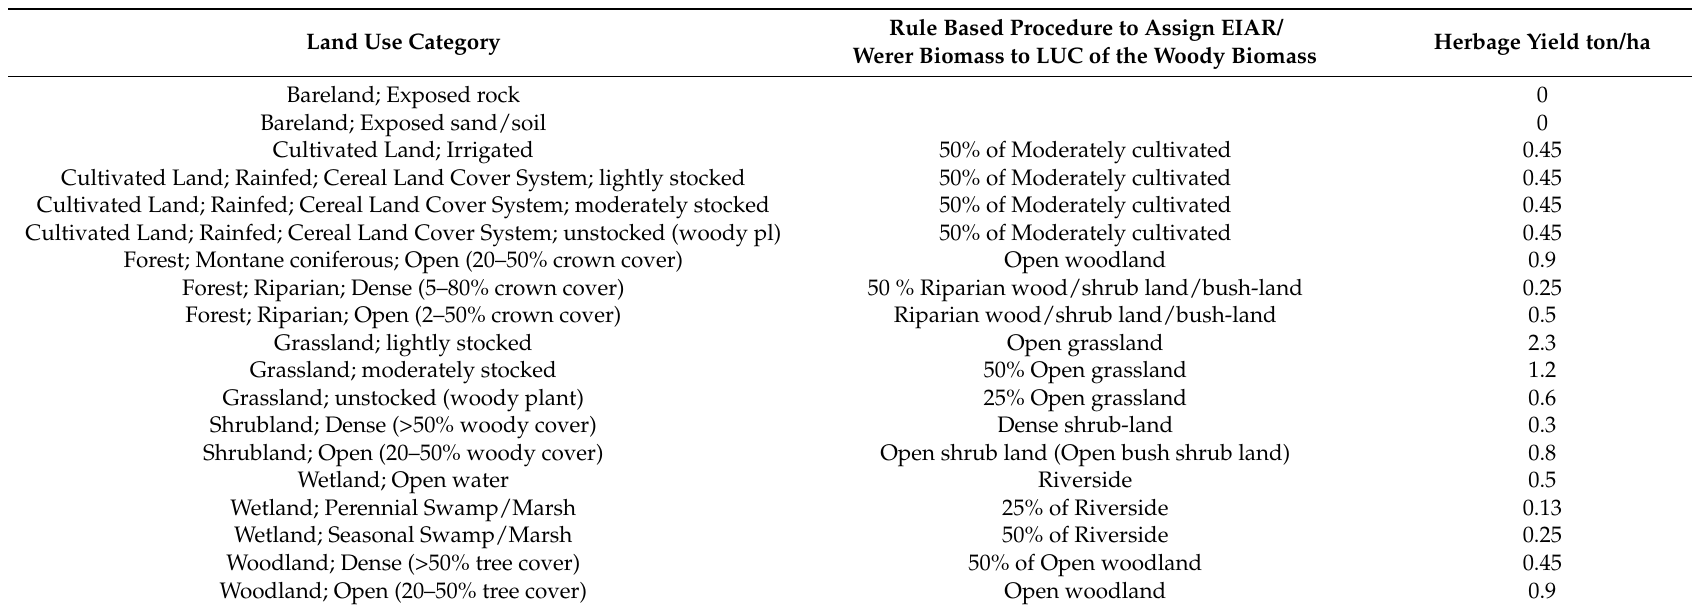
Table 3. Rule based procedure to map biomass assessment for land use categories in the Woody Biomass project. Land Use